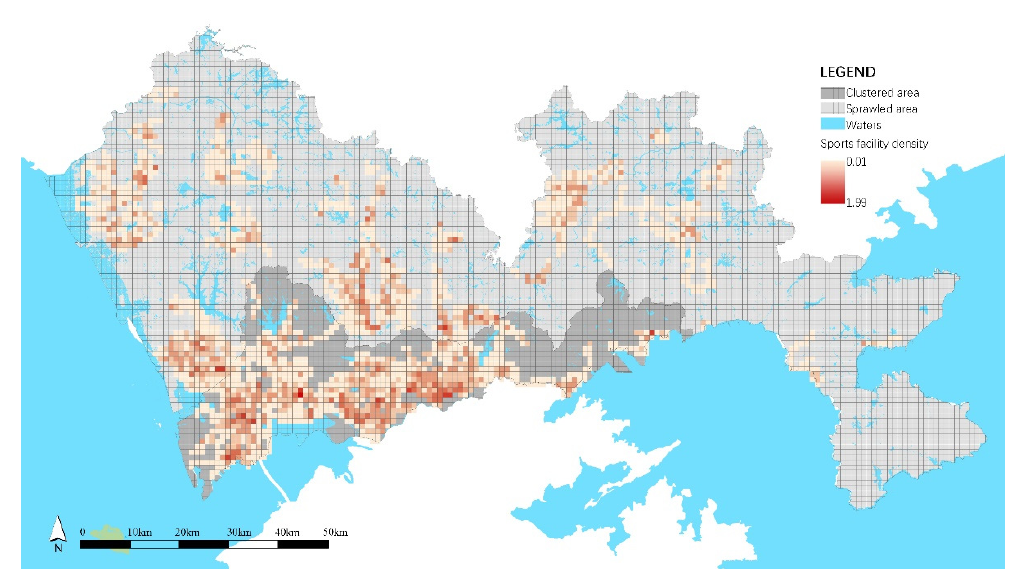
Figure 5. Spatial distribution of sports facility density. Table 8. Regression models and results.